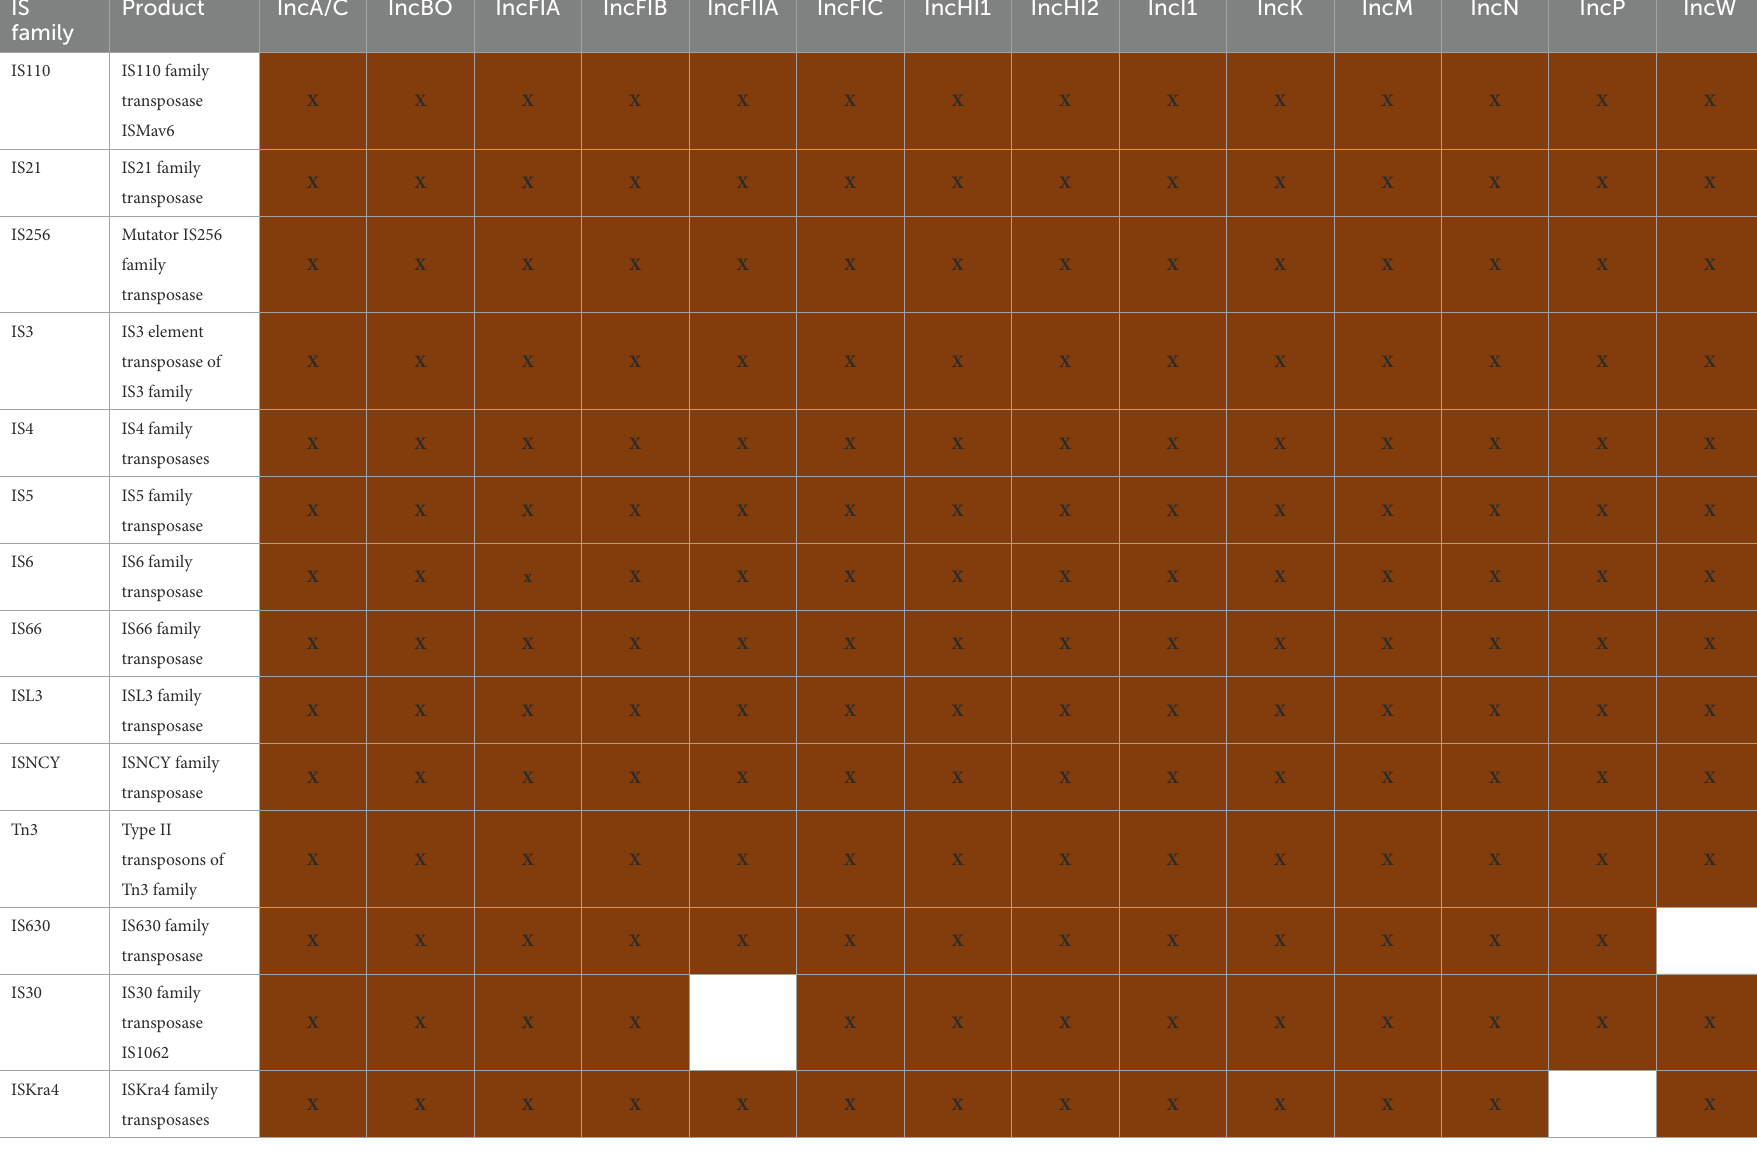
TABLE 5 IS families detected (brown box) in the representative plasmid types using